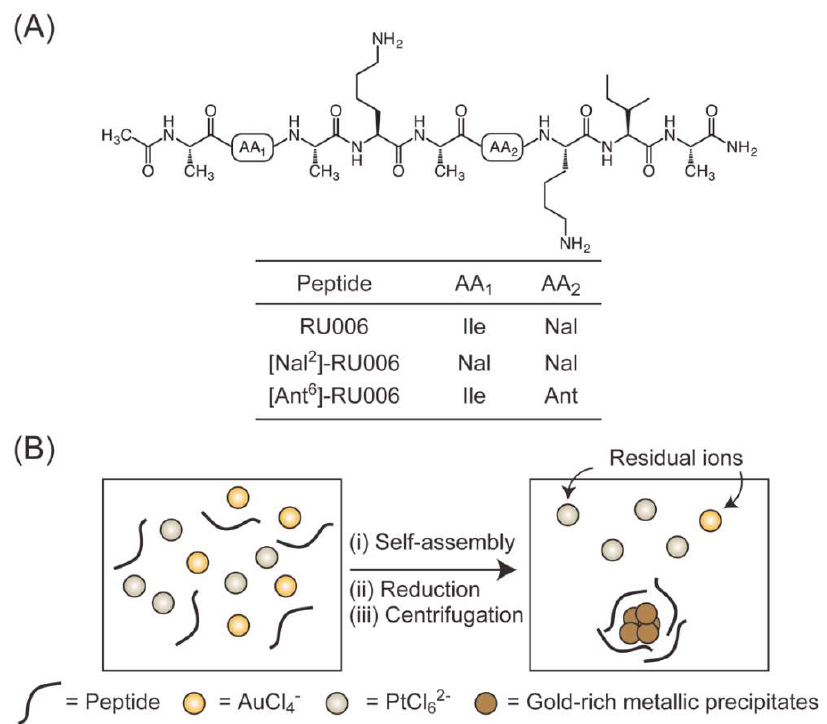
Figure 1. Amino acid sequences of the amphiphilic nonapeptides. ( A ) The original nonapeptide RU006 and (NaI 2 )-RU006 and (Ant 6 )-RU006. ( B ) Illustrative representation of selective gold recovery from a homogeneous aqueous solution containing gold and platinum ions by peptides. Abbreviations: NaI = L-2-naphthylalanine and Ant =